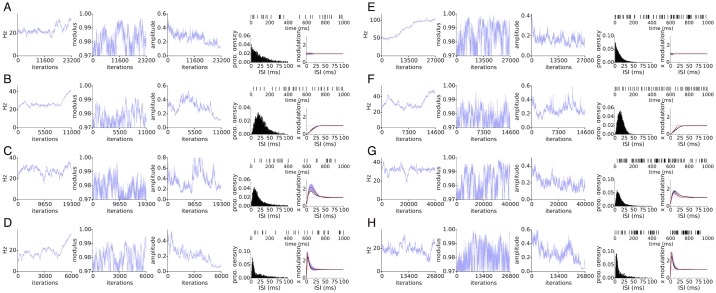
Spike trains without oscillatory modulation.Simulated spike trains at 34Hz (A-D) and 60Hz (E-H), with 4 types of post-spike refractory profiles. Each panel shows Gibbs samples on left and on the right, an example spike train at the top, and the ISI histogram and spike history function as in Fig 1. The expected output of LOST is a nearly flat latent state, which is the case in A, B, D, E, G, H, accompanied by large variability in the other sampled parameters. In C and F, the amplitude of the latent state does not approach 0, but rather continues to fluctuate while taking larger values.